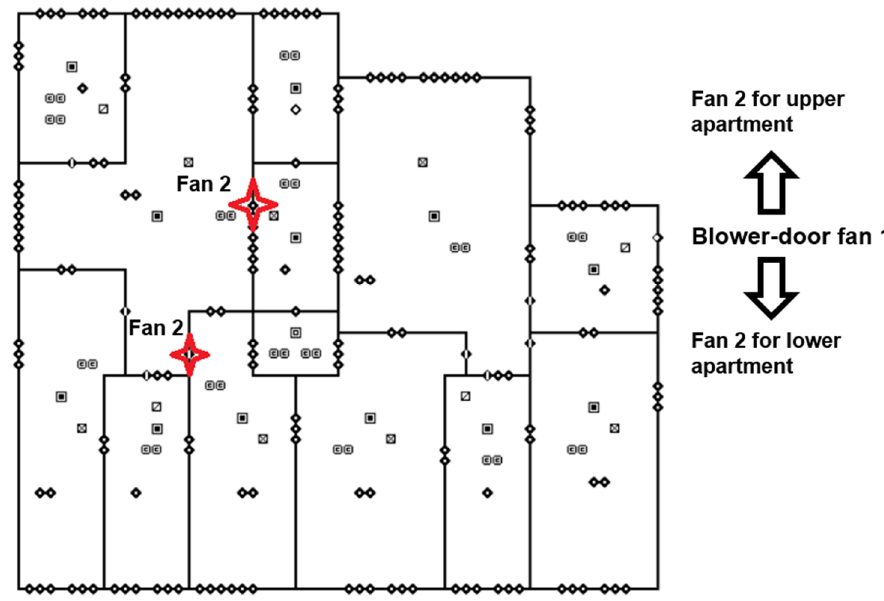
Figure 9. The places of Fan 2 for proposed experimental method.